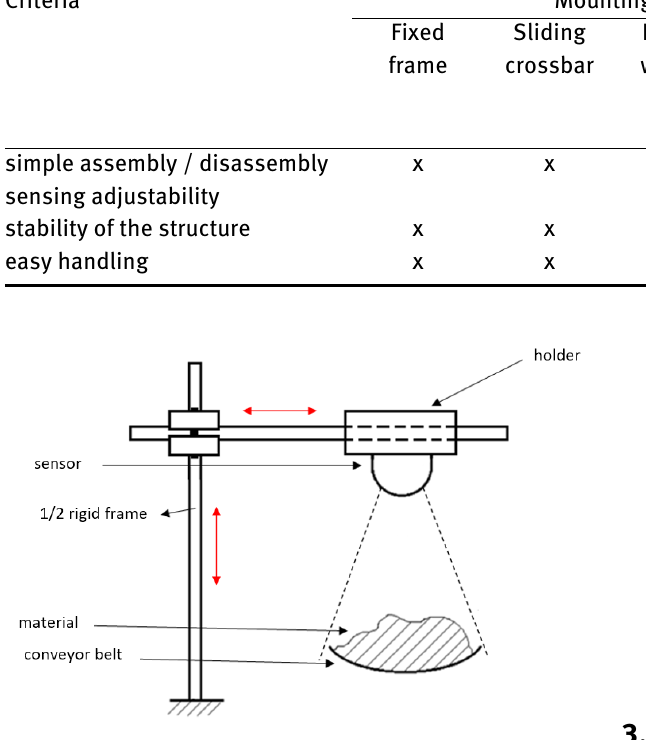
Figure 10: 1/2 Rigid frame with 1-axis sliding crossbar and fixed